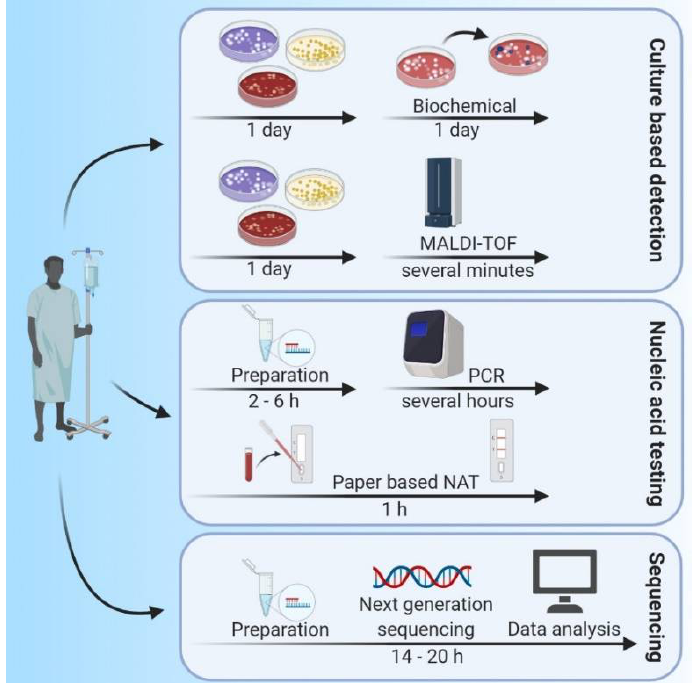
Figure 1. Typical timeframes required for techniques in current use for the diagnosis of bacterial infections. The classical cultivation of biological specimens, in combination with biochemical char- acterization, requires ~42 h as a minimum estimate. Replacement of biochemical methods with MALDI-TOF mass spectrometry (MS) reduces this timeframe significantly. The use of nucleic acid testing (NAT) bypasses the initial cultivation of clinical specimens, and thus reduces the timeframes to fewer than 4 h. However, NAT methods are sequence-dependent and involve only a limited number of primer-combinations; as such, these methods require a priori knowledge of the suspected pathogen(s). The use of NGS-based methods eliminates the need for any a priori knowledge of a suspected pathogen, although typical timeframes are